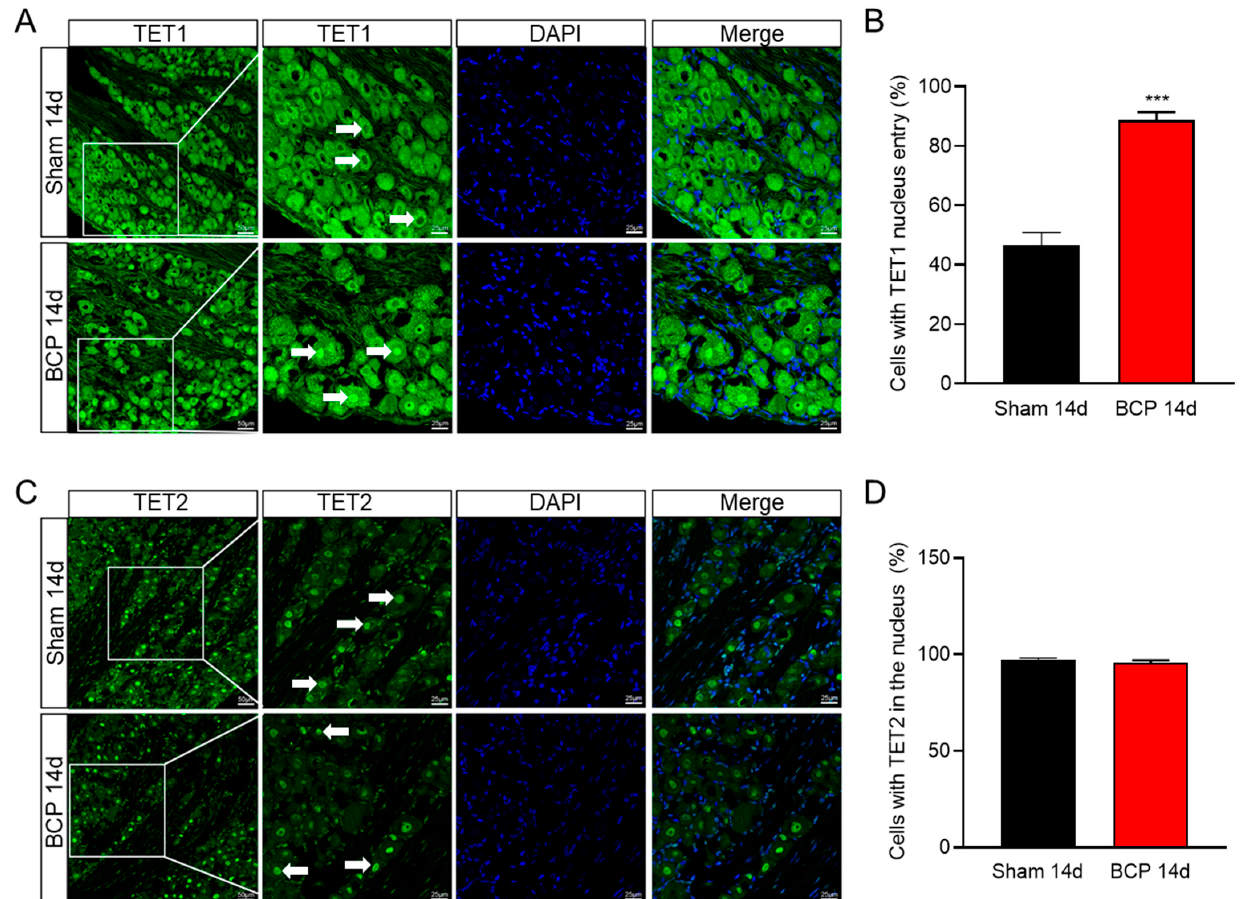
Figure 4. Immunofluorescence assay of TRPV4 in the L4–6 DRG of BCP rats. ( A ) The schematic diagram. ( B ) TRPV4-positive DRG cells (middle row) were mainly co-labeled as neurons (NeuN) but not with satellite glial cells (GS). TRPV4 was co-expressed in CGRP-positive and IB4-positive DRG neurons. ( C ) The proportion of TRPV4-positive cells in different cell types, n = 4.